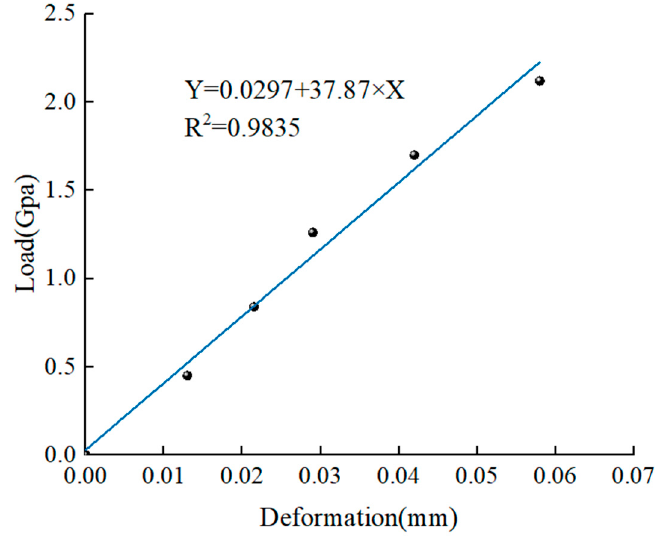
Figure 3. The fi tt ing curve of the pressure plate test at the No. six test point. Figure 3. The fitting curve of the pressure plate test at the No. six test point.